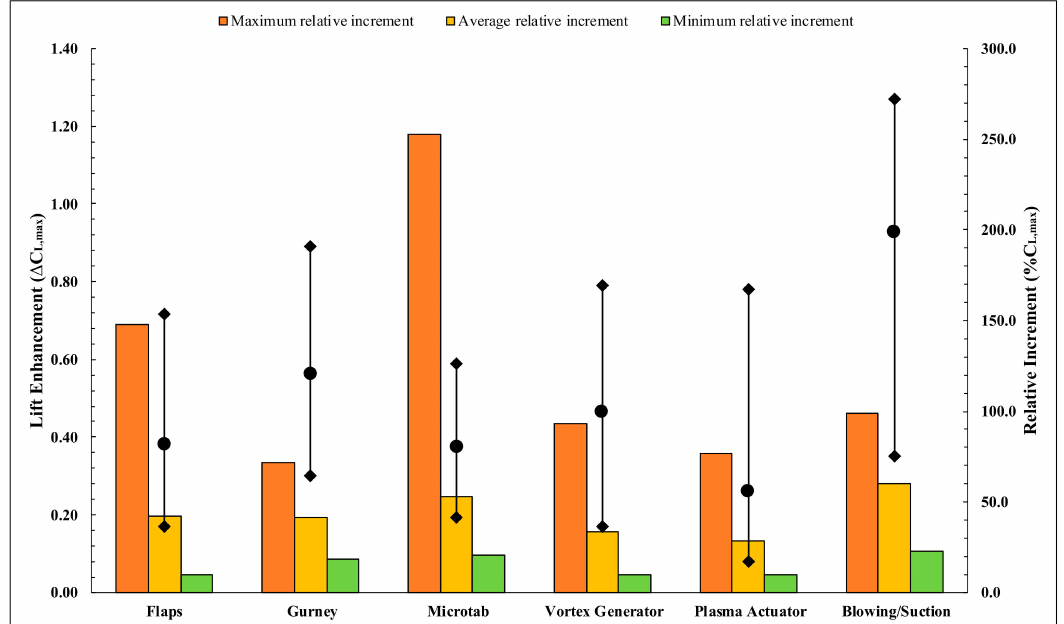
Figure 11. A comparative plot indicating maximum, average, and minimum lift enhancements ( ∆ C Lmax ) and relative lift increments (%C Lmax ) achieved by different flow-control